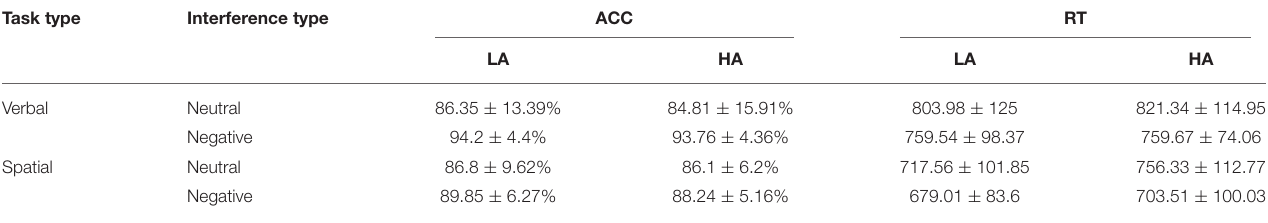
TABLE 1 | Basic descriptive statistics of ACC and reaction time (RT) in both